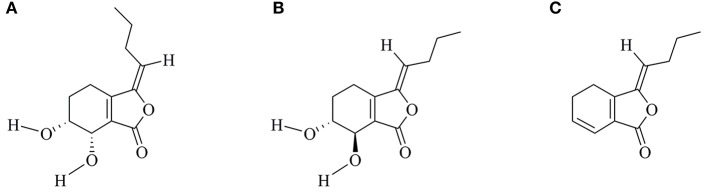
Chemical structures of SEH (A), SEI (B), and LIG (C). SEH, senkyunolide-H; SEI, senkyunolide-I; LIG, Z-ligustilide.